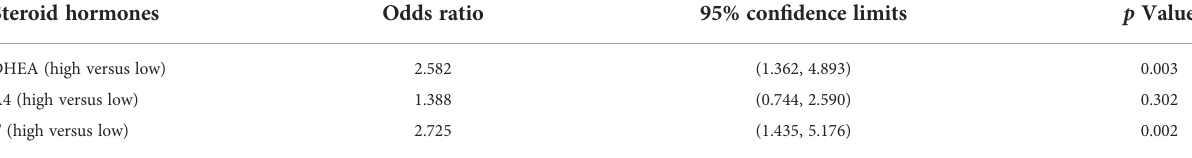
TABLE 3 Calculated odds ratio (OR) for GDM. Steroid hormones